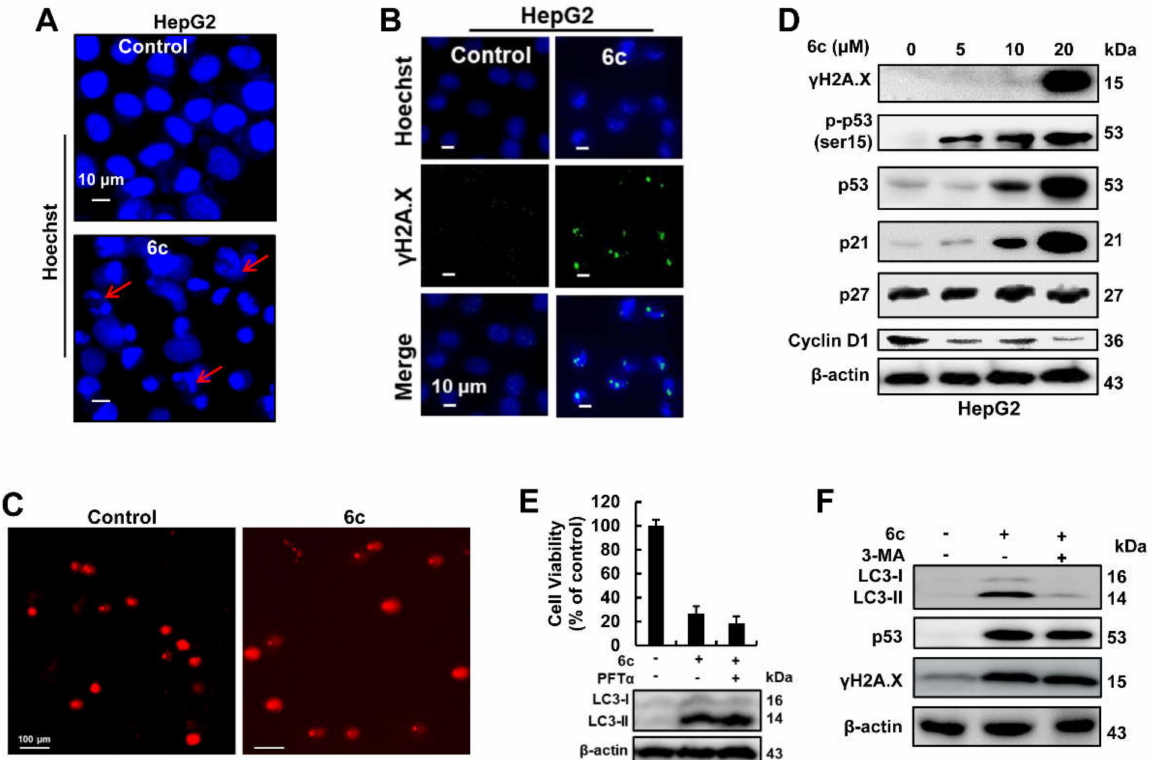
Figure 4. Compound 6c induced DNA damage in HepG2 cells. ( A ) Shape changes of nucleus after 6c (20 µ M) treatment for 24 h in HepG2 cells. 6c-treated cells were stained with Hoechst 33342, and the images were captured using confocal microscopy. ( B ) The foci of γ H2A.X in HepG2 cells treated with or without 6c (20 µ M) for 24 h were detected using confocal microscopy. ( C ) Representative images of alkaline comet assay. HepG2 cells were treated with or without 6c (20 µ M) for 24 h. ( D ) The expression of proteins related with DNA damage and p53 pathway after 6c treatment for 24 h was determined using Western blot. ( E ) Effects of p53 inhibitor PFT α on 6c-induced cell viability inhibition (up) and LC3-II expression (down). HepG2 cells were pretreated with PFT α (10 µ M) for 1 h followed by treatment with 6c (20 µ M) for 24 h. Cell viability was tested using MTT assays, and the expression of LC3 was detected using Western blot. ( F ) The expression of LC3, p53, and γ H2A.X was determined using Western blot. HepG2 cells were pretreated with 3-MA for 1 h followed by treatment with 6c (20 µ M) for 24